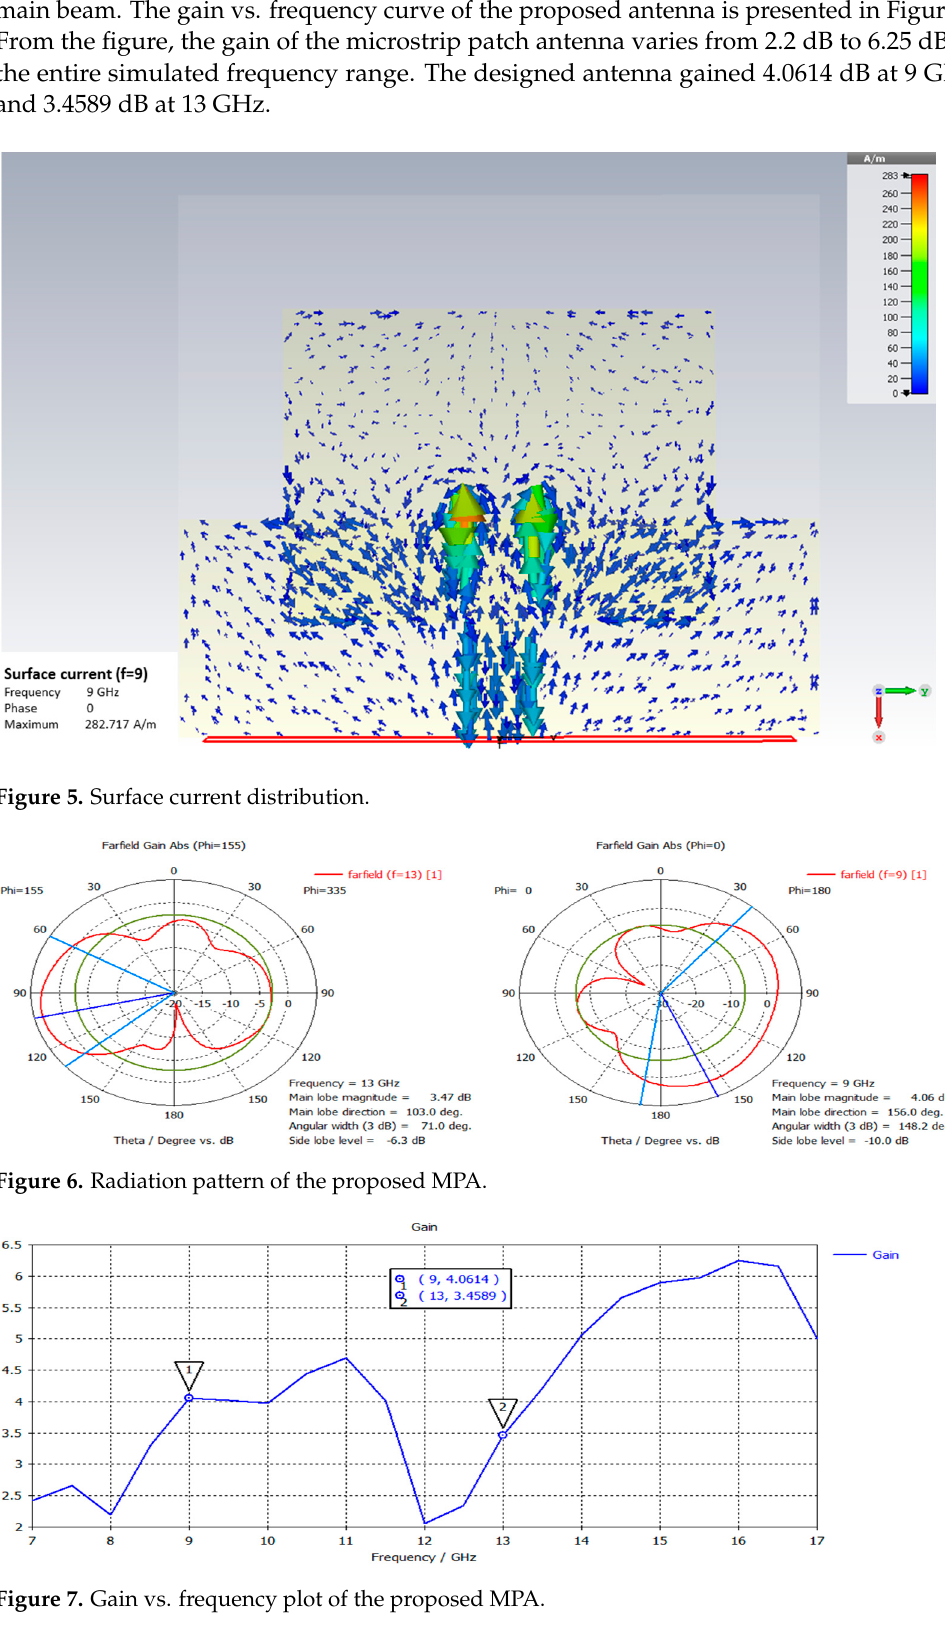
Figure 7. Gain vs. frequency plot of the proposed